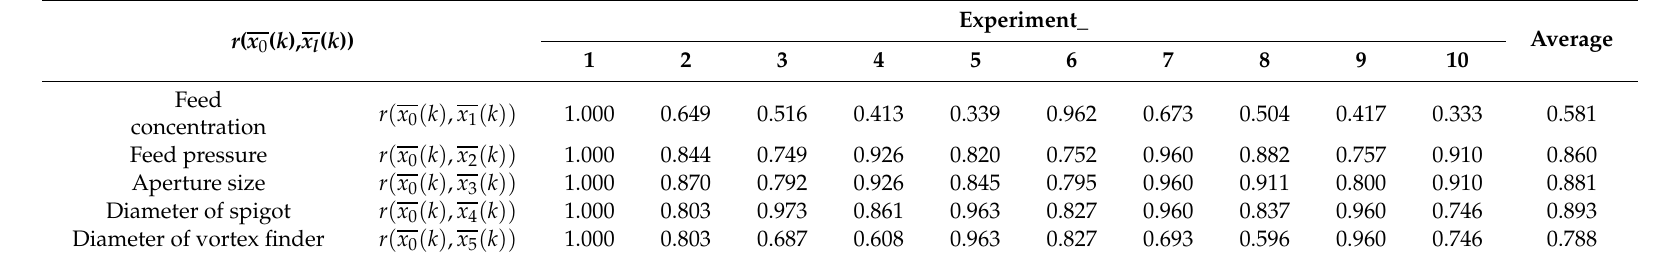
Table A3. Closeness of Grey System theory for